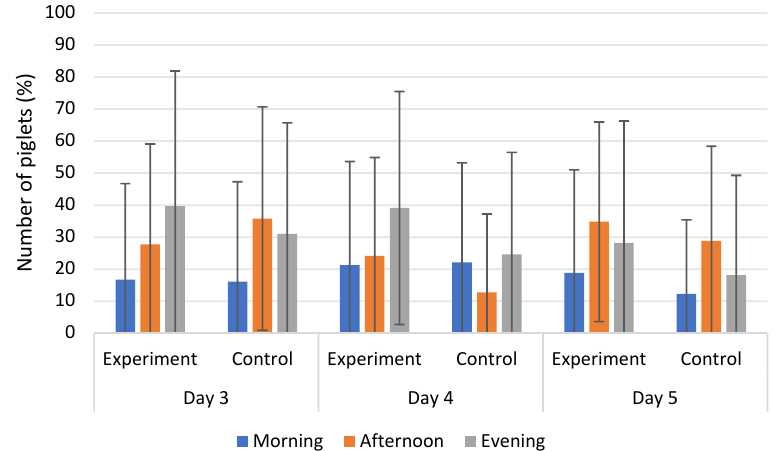
Figure 5. Mean percentage of suckling piglets per litter in the experimental and control groups in the morning (6.00–10.00), in the afternoon (13.00–17.00), and in the evening (19.00–21.00). Day 4 = day of vaccination.